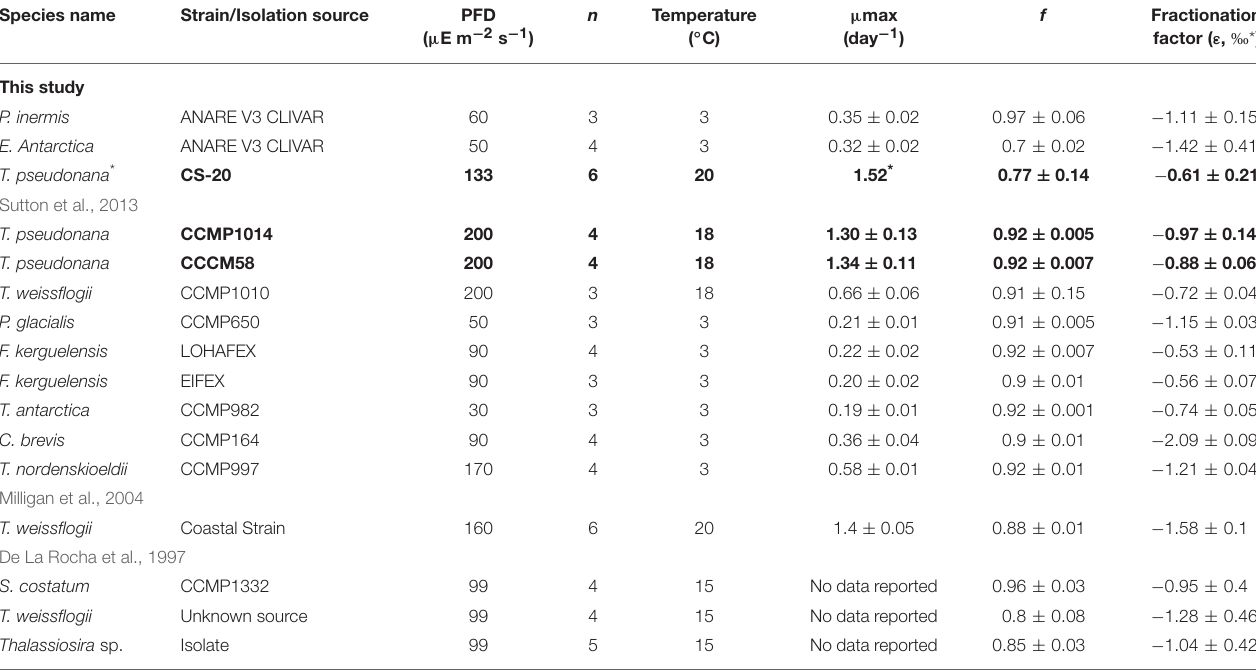
TABLE 2 | Comparison of Fe-replete, Si-isotope fractionation factors ( ε , ‰ ) between this study and previous studies. n is the number of replicate cultures. Species